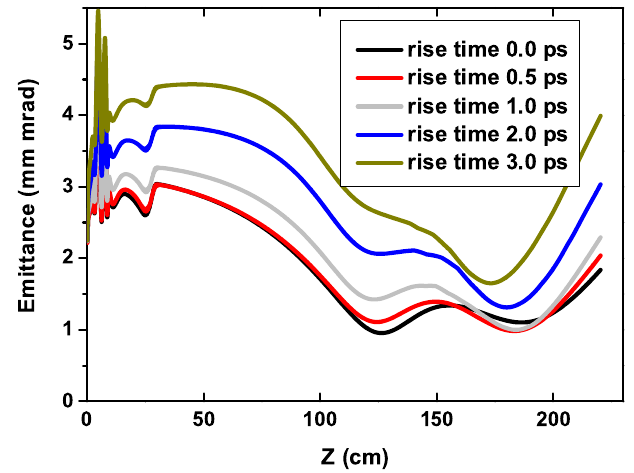
FIG. 1. (Color) Simulation of emittance from the rf gun cathode along the beam line showing the dynamical behavior of the beam for several laser pulse rise times.